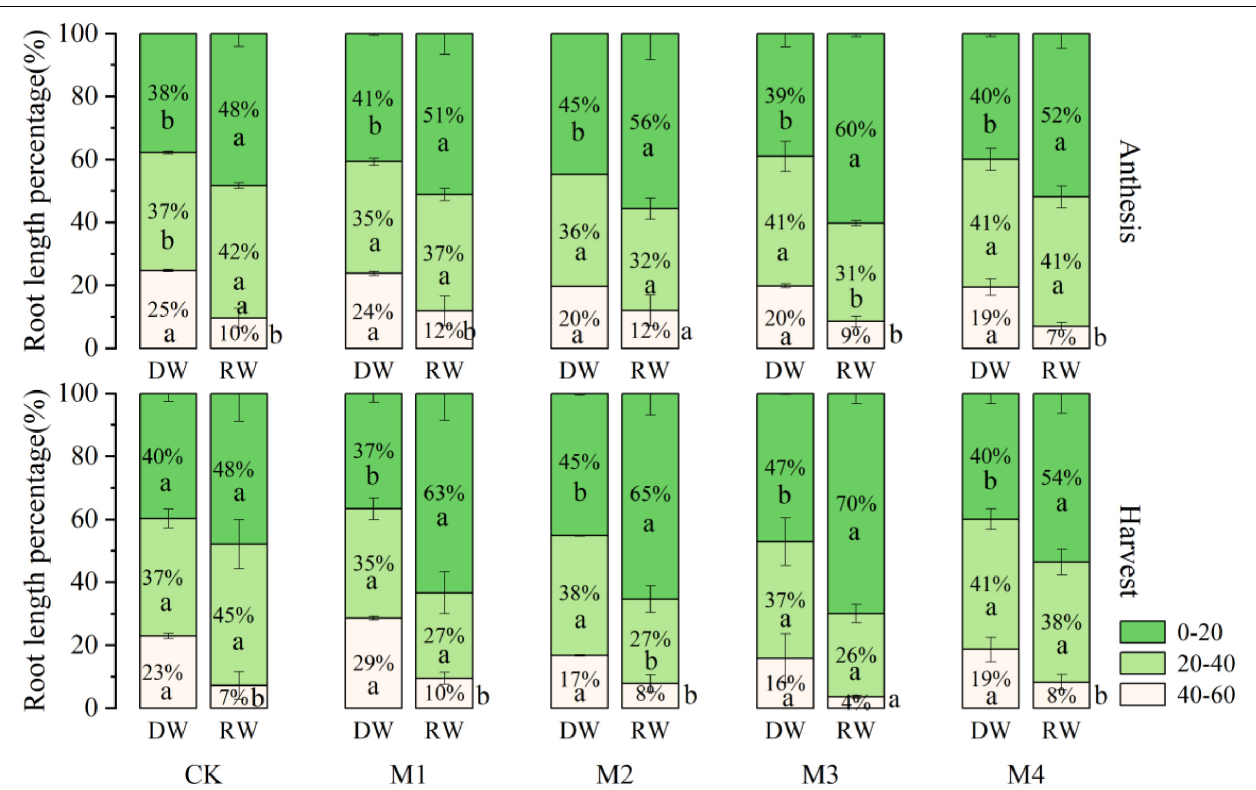
FIGURE 6 | The distribution of wheat roots in 0–60 cm soil, presented by the root length percentage at varying N fertilization under different cropping system at anthesis and harvest stages.